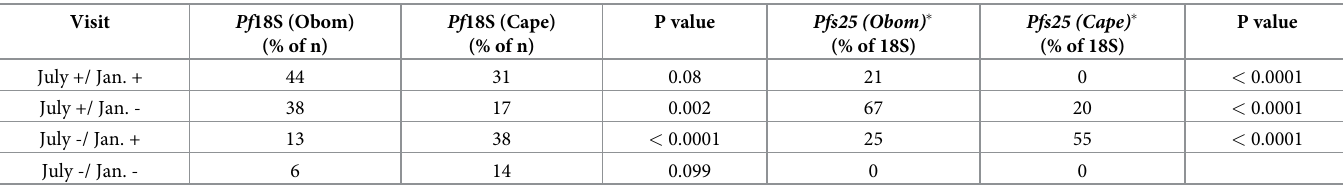
July +, positive / infected in July; July -, negative / not infected in July; Jan. +, positive / infected in January; Jan. -, negative / not infected in January; n, total count; Obom, n = 29 for Cape Coast). Pf 18S is reported as a % of the total number of paired children but Pfs25 is reported as a % of 18S positive (parasitaemic)